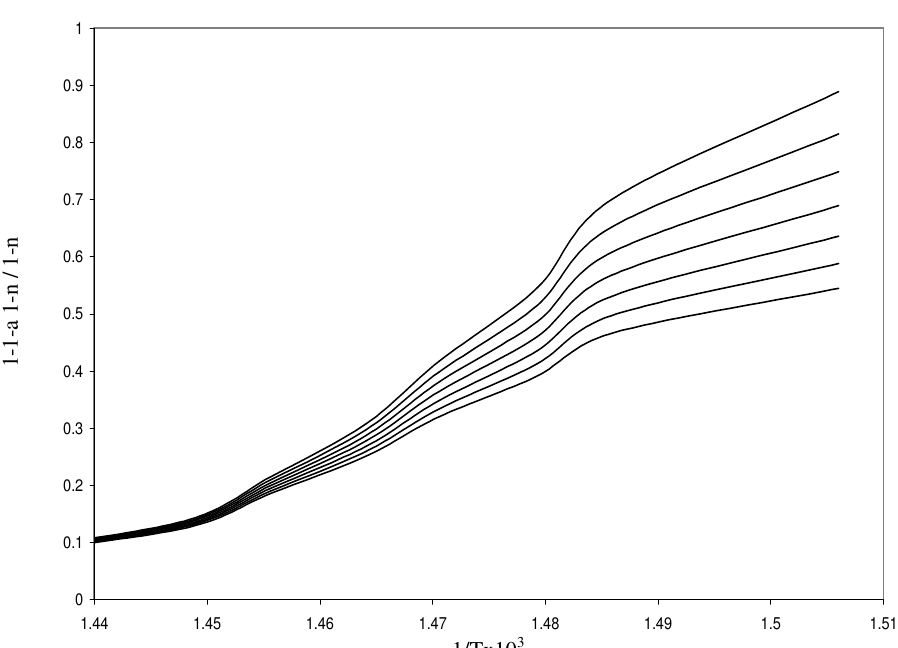
Figure 9. Plot between – log